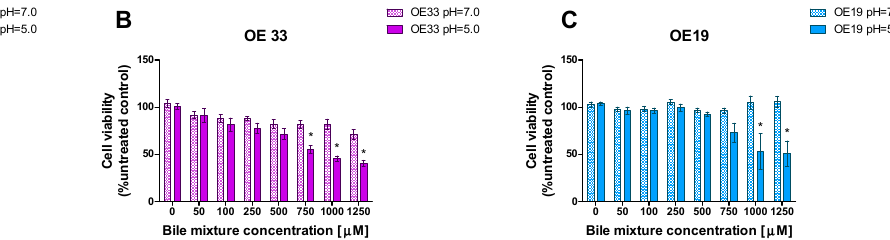
Figure 2. The viability of cells in different developmental stages of Barrett’s esophagus (BE) and esophageal adenocarcinoma (EAC) exposed to various concentrations of bile mixture (BM) applied in pH 5.0 and pH 7.0. BAR-T ( A ), OE33 ( B ) and OE19 ( C ) were treated for 30 min with 50–1250 µ M of BM. Results are shown as the mean ± SEM. Asterisk (*) indicates a statistically significant difference as compared with respective BM concentration applied in pH 5.0 ( p < 0.05).